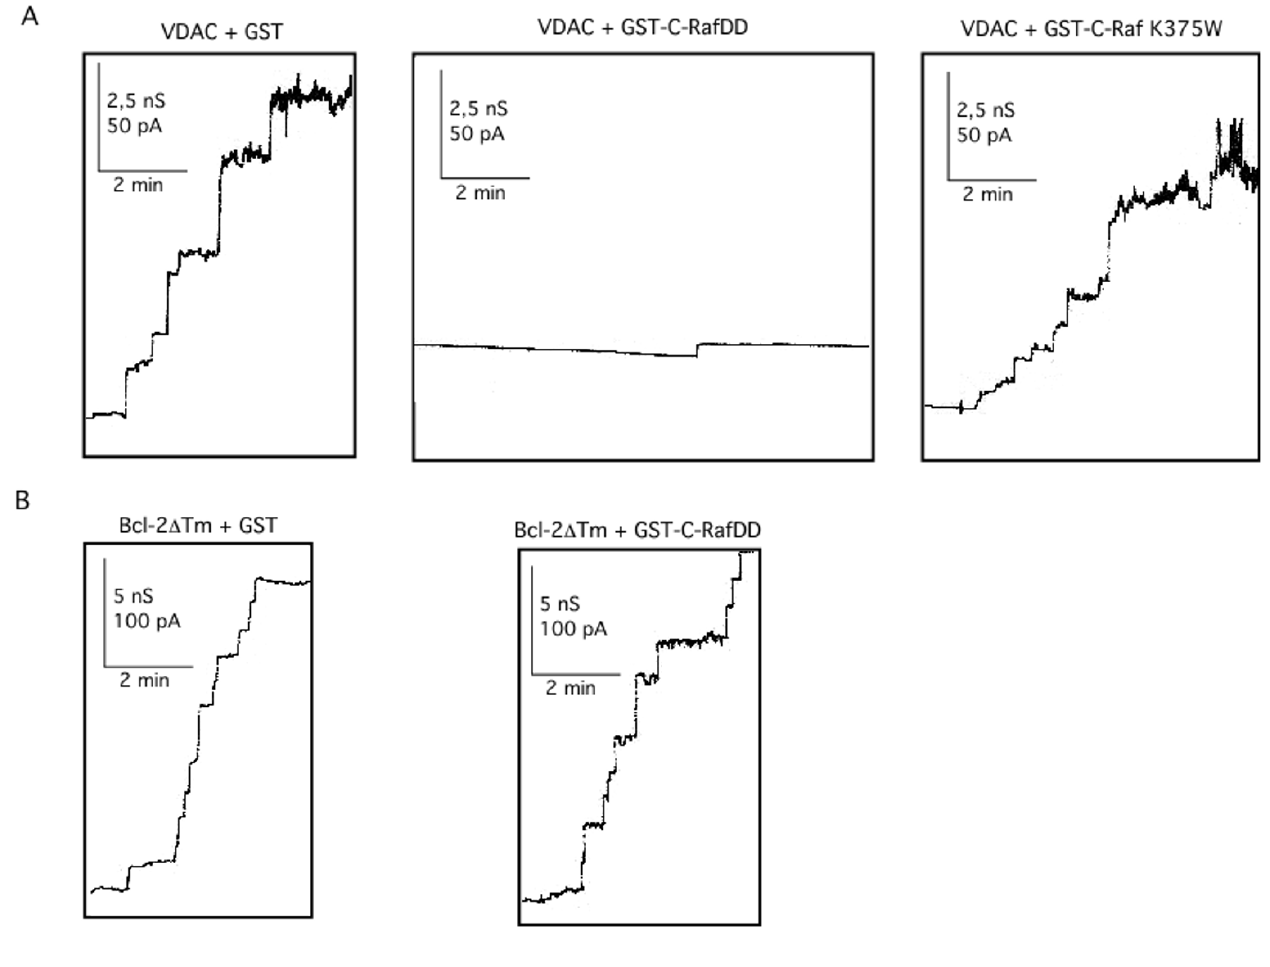
Figure 6 C-Raf kinase inhibits the VDAC channel function. Single channel recordings of purified rat liver VDAC protein in a DiphPC mem- brane. VDAC or Bcl-2 ∆ Tm were preincubated with active GST-C-RafDD, inactive GST-C-RafK375W, or GST recombinant proteins before channel conductance measurement (A,